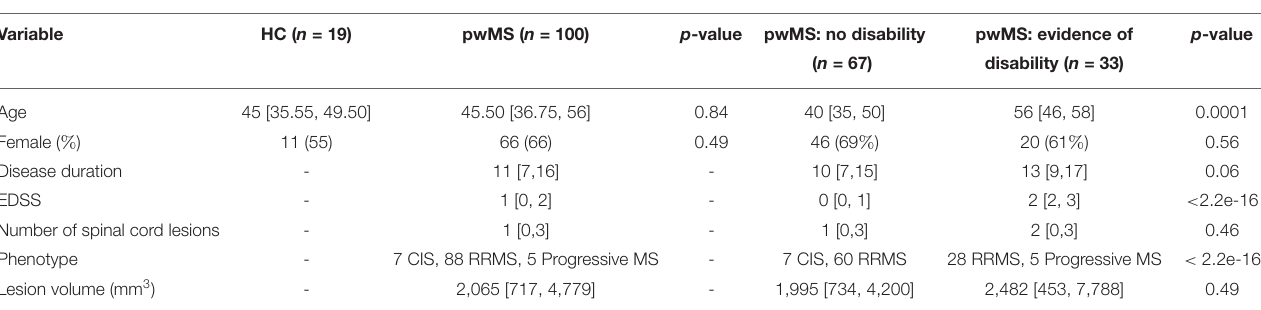
TABLE 1 | Subject demographics and clinical